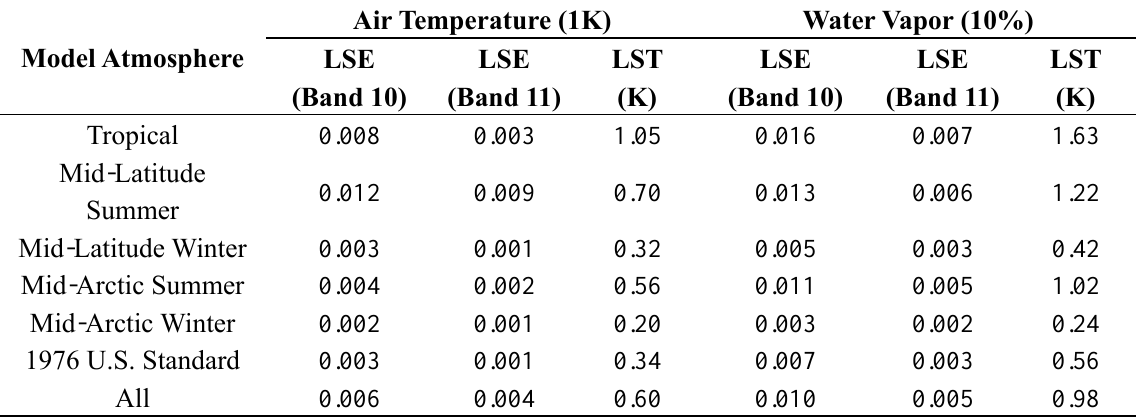
Table 5. Uncertainty of the derived LST/LSE for different sources of